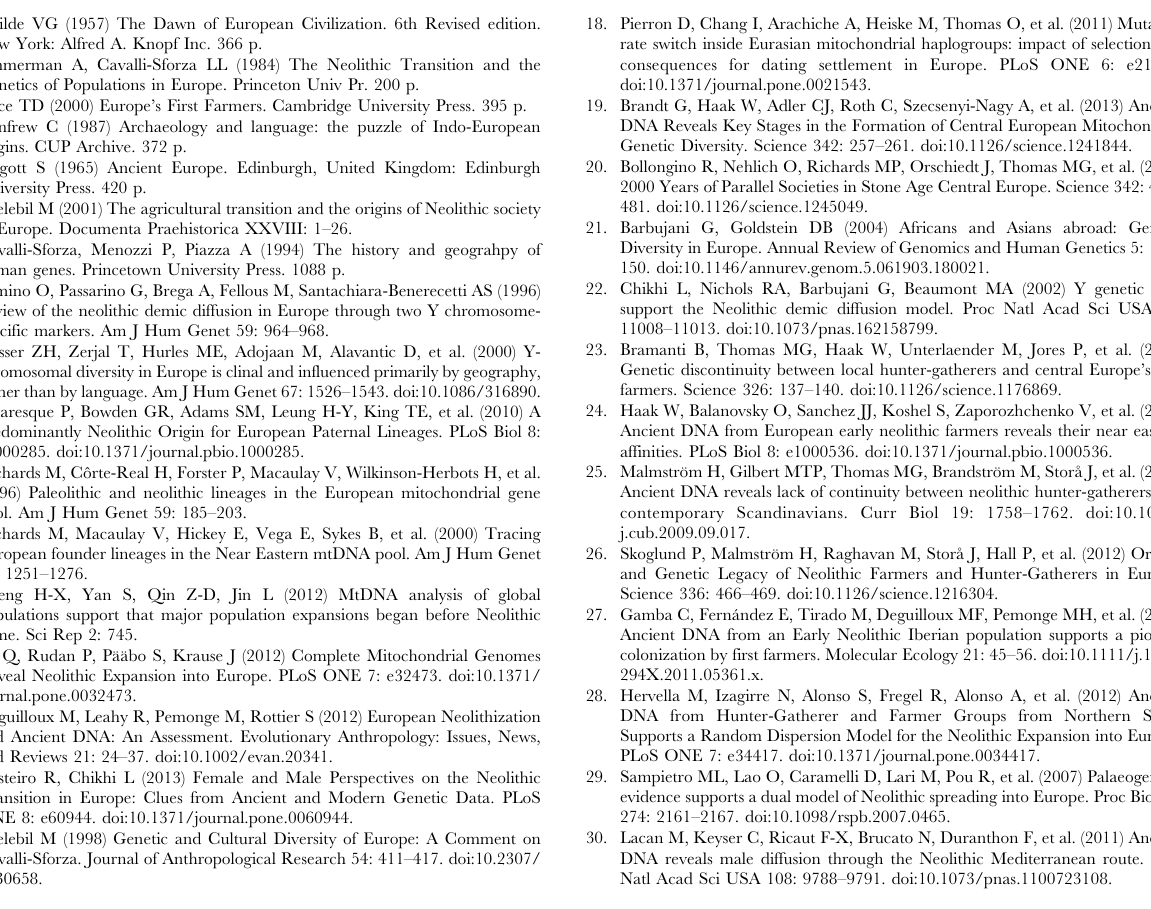
Table S11 HVS1 mtDNA sequences of the research and laboratory staff involved in sample handling. Only positions 16,126–16,369 are presented. Table S12 Mitochondrial DNA primers used in this